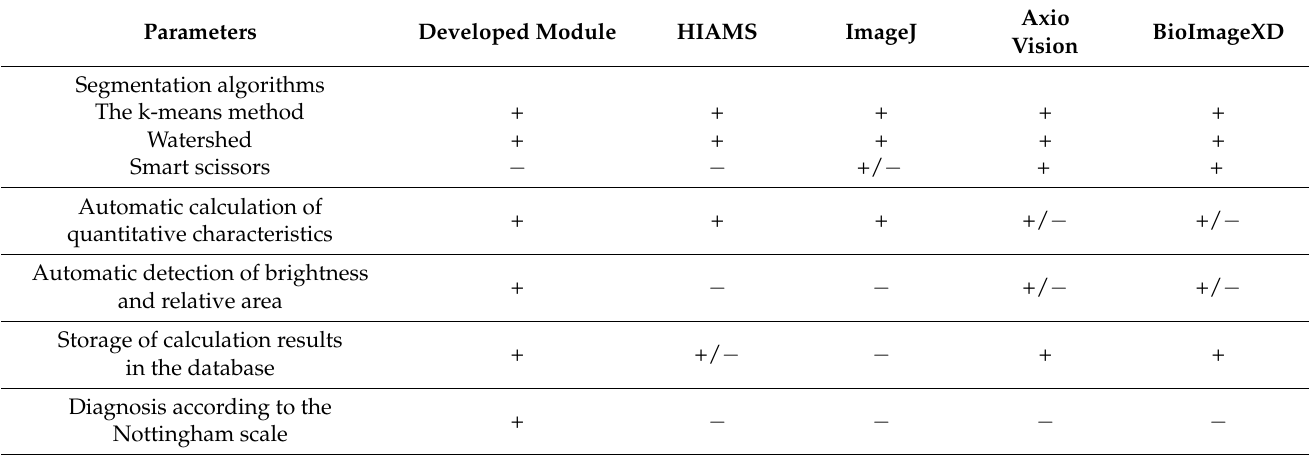
Table 2. Comparative analysis of automated microscopy systems (“+”—criterion is present, “ − ”—criterion is absent, “+/ − ”—criterion is implemented in automated